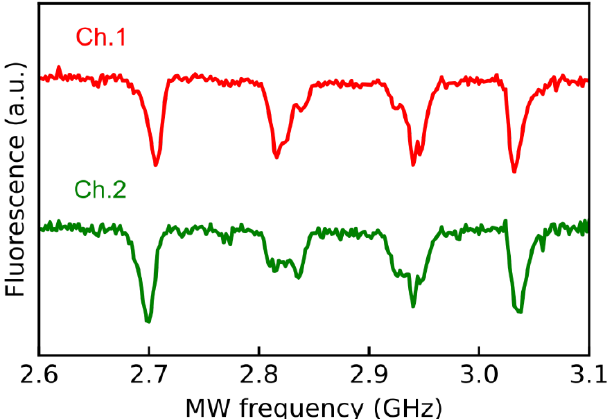
Figure 2. Typical optically detected magnetic resonance (ODMR) spectra of the spatially isolated diamond samples of sensor 1 (Ch. 1) and sensor 2 (Ch. 2). The detected fluorescence at each detector is about 0.2 mW. The ODMR signals (dips) of the left and right sides correspond to magnetic sublevels m s = − 1 and +1, respectively, for the NV center with [111] direction. The resonance of the other three of the four orientation axes is degenerate. Our microwave circuit drives the NV center with [111] direction most effectively. For each sensor, the noise voltage of the ODMR measurement is 0.057% of the signal voltage of the fluorescence.